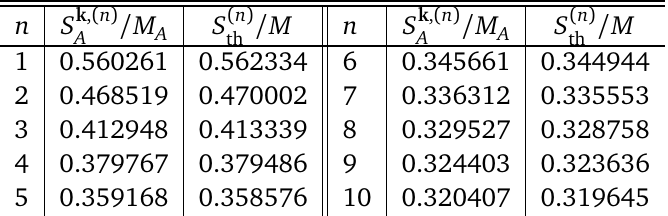
Figure 1: Upper panel : S k computed from Eq. 21 for three different distributions in the Brillouin A zone: a Fermi sea distribution (a), a regular pattern with a small random offset (b) and a fully random distribution (c). The distributions are shown as an inset of the lower panel, each black = 16384 particles pixel being an occupied state. The system has M = 256 × 256 sites with N k / L and and N = 2048 pairs. The region A is a square of perimeter L . We actually show S k A we have rescaled the values obtain for (a) by a factor of 10. The lines are the free Fermi gas entropies ˜ S k . Note that the distribution (b) has a crossover between area law (for small L ) A and L ln L (for large L ). Lower panel : Difference between S k and the von Neumann entropy of A the free system ˜ S k as a function of L for the three distributions. The dashed line is the analytic A difference given by Eq. 22.